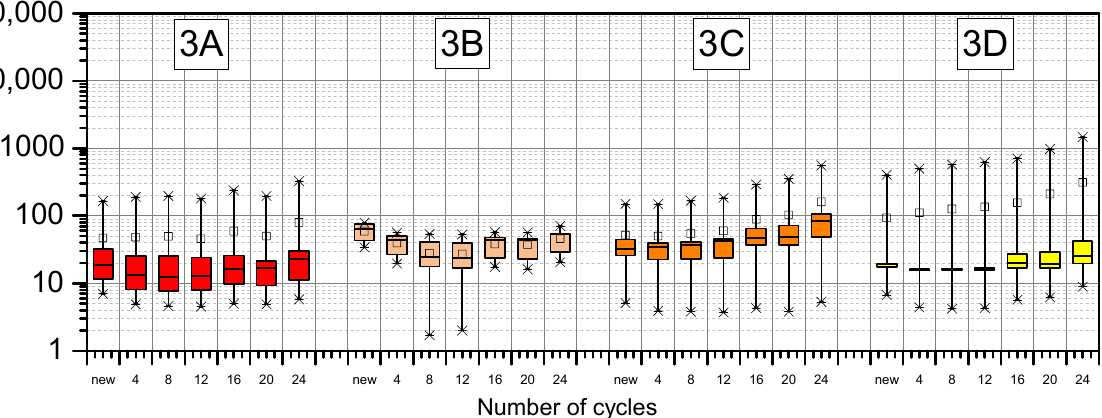
Figure 14. Boxplot diagram of graphene sensor (third sample type—square shape) electrical resistance for samples 3A, 3B, 3C and 3D.